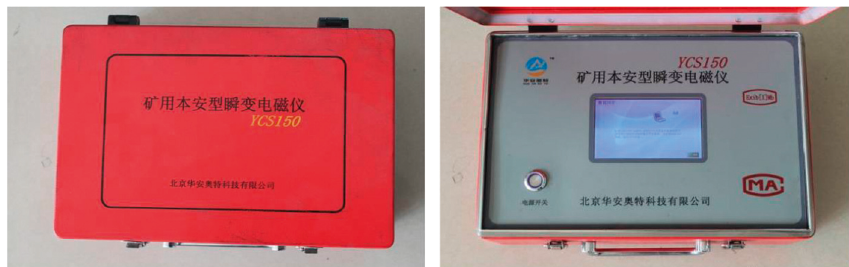
Figure 19: Host of mine intrinsically safe transient electromagnetic instrument.